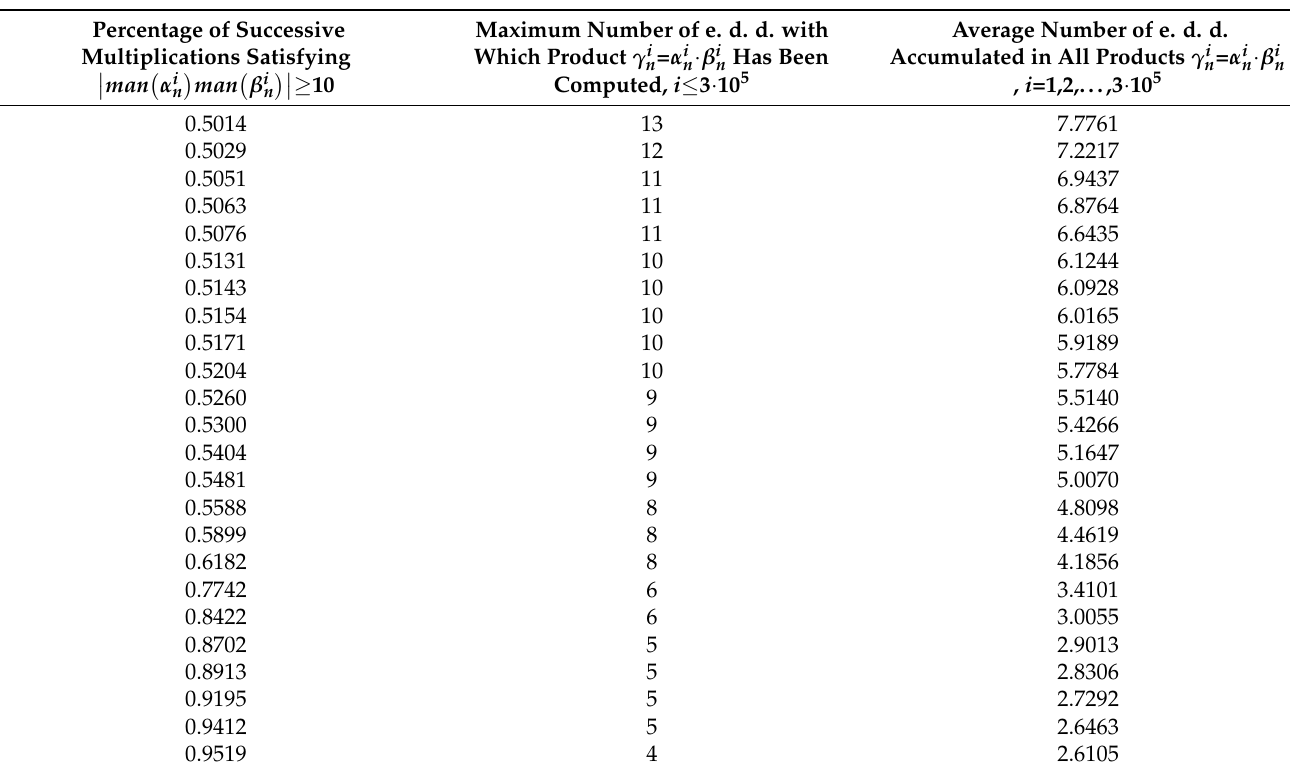
Table 8. Demonstration of the results of experiment associated with Case 3, described in the Section 4: 3 × 10 5 successive multiplications γ i n = α i n · β i n have been performed for various percentages F g of them satisfying The obtained maximum and average numbers of e. d. d. are in full accordance with Theorems 1, 3 and 5. In fact, when F g > 50% holds, then the evaluated products manifest a considerable resistance to finite precision error. The closest to 1 F g is, the smaller the number of erroneous digits with which all γ i n are computed, exactly as predicted by the theoretical